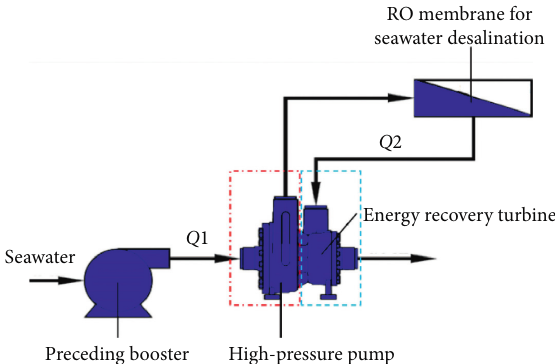
Figure 1: Flowchart of reverse osmosis desalination process.